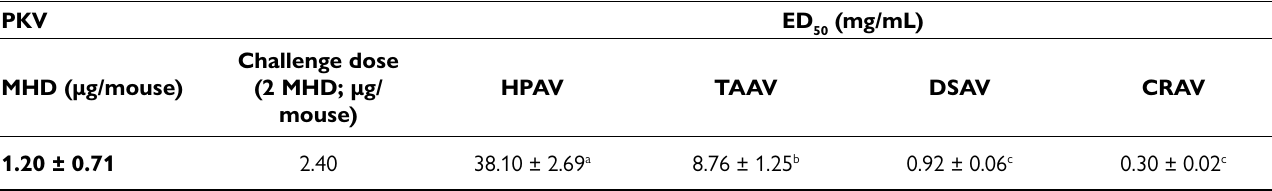
a,b,c Means within a row with different superscripts between groups of each measurement differ significantly (p < 0.05). MHD: minimal hemorrhagic dose was defined as the amount of venom (µg) required to induce a hemorrhagic skin lesion of 10 mm diameter; ED capable of reducing a venom’s hemorrhagic activity of 2MHD by 50%. ED